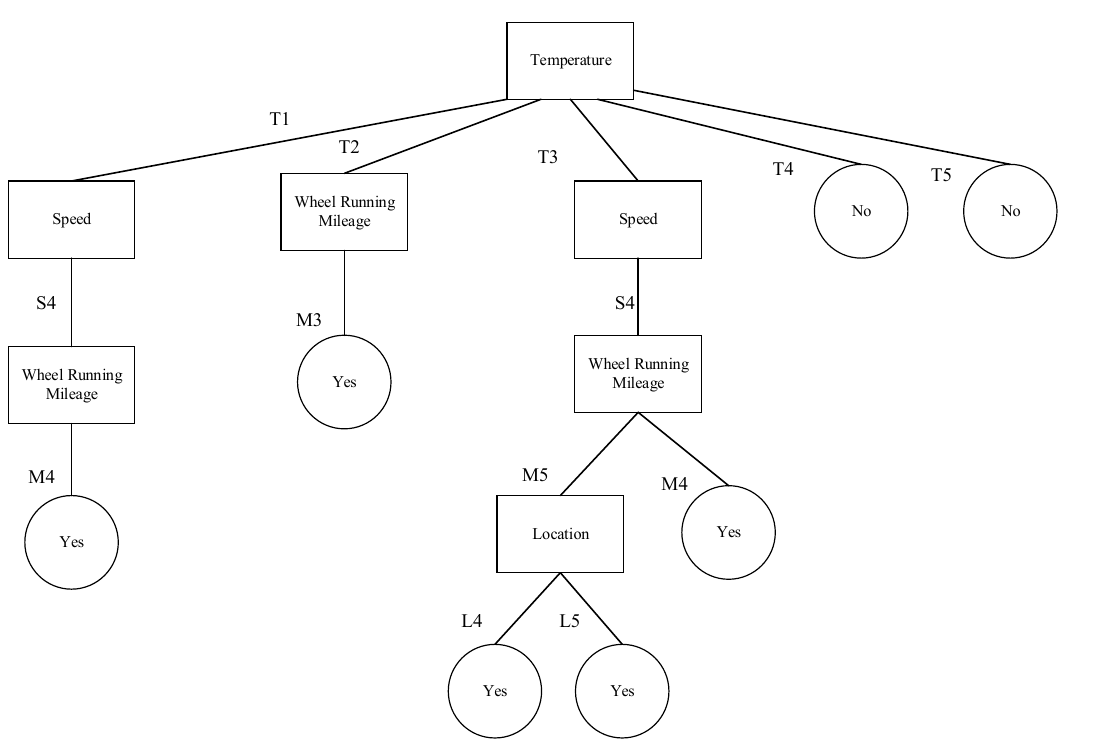
Figure 9. A decision tree for predict BIDS alarms with or without maintenances.